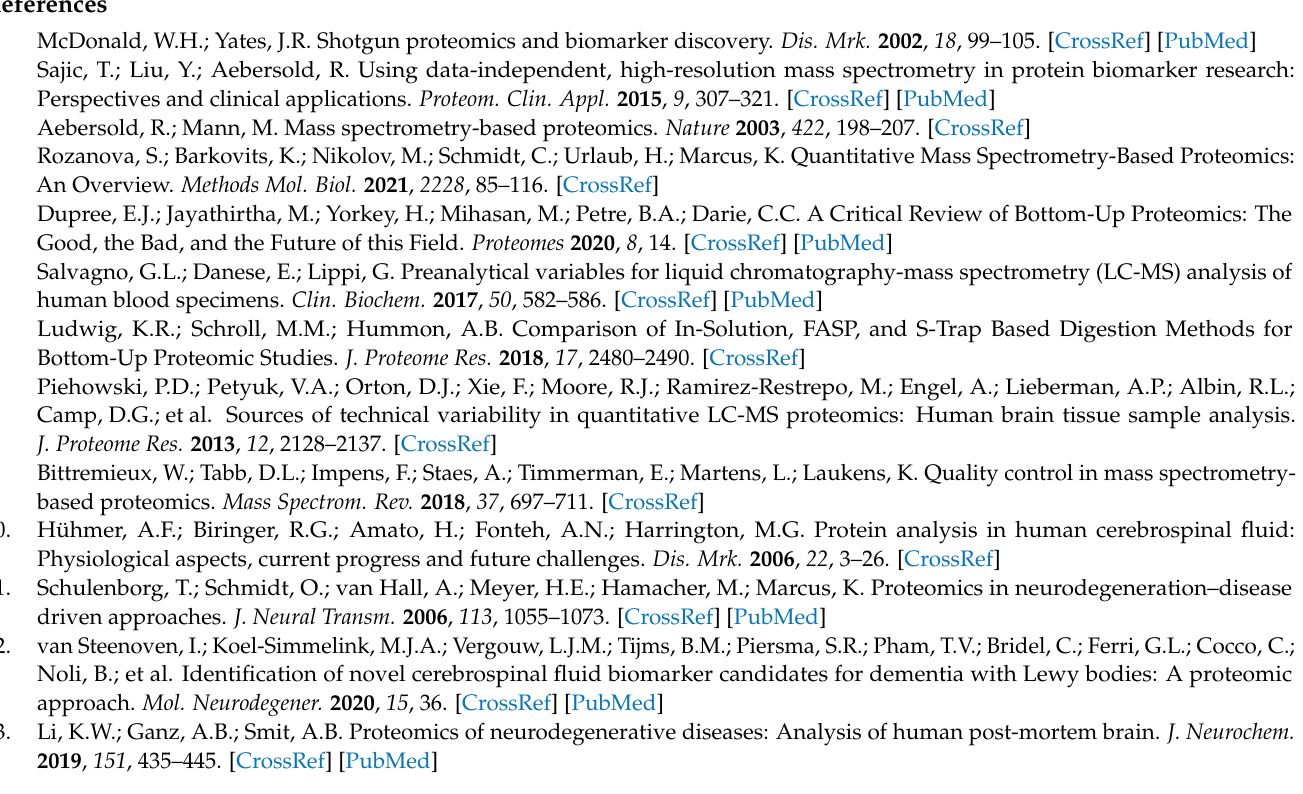
for different CSF datasets. Figure S3: Raw data quality assessment: quantile analysis of MS1- and MS2- ion intensities. Figure S4: Boxplots based on the protein intensities. Figure S5: Analysis of MA plots based on raw and LOESS-normalized intensities of PGs. Table S1: The number of peptides and PGs quantified in the four datasets. Table S2: Raw data features taken for the PCA analysis and the scores. Table S3: Modifications found using MASCOT error tolerance search. Table S4: The number of peptides and PGs quantified in the four datasets. Table S5: Summary of the results obtained for different datasets. Correlations_peptides.xlsx; Correlations_proteins.xlsx; and